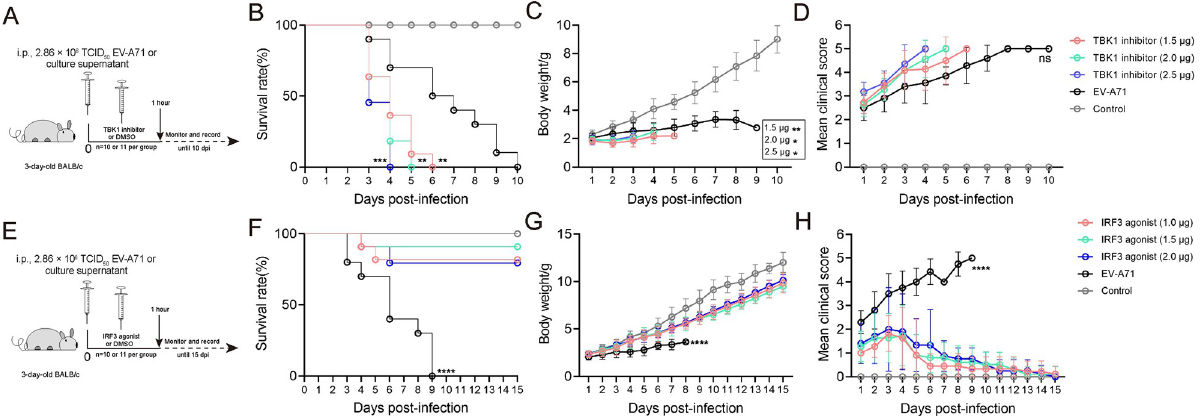
Fig 1. TBK1 and IRF3 interventions on EV-A71-induced disease severity in a neonatal mouse model. (A ) and ( E ): The experimental design of TBK1 and IRF3 intervention. For TBK1 intervention, EV-A71 infected mice were treated with TBK1/IKK ε -IN-2 (TBK1 inhibitor) via i.p. at a dose of 1.5, 2.0 or 2.5 μ g per mouse at indicated time points. For IRF3 intervention, EV-A71 infected mice were treated with KIN1148 (IRF3 agonist) via i.p. at a dose of 1.0, 1.5 μ g or 2.0 μ g per mouse at indicated time points. Survival rates ( B , F ), body weight ( C , G ), and clinical scores ( D , H ) of mice were monitored and recorded daily up to 10 or 15 days after inoculation. Data represent the mean ± SD. TBK1 and IRF3 interventions mice with EV-A71 infection vs EV-A71-infected mice; � P < 0.05; �� P < 0.01; ��� P < 0.001; ���� P < 0.0001; ns, no significance.